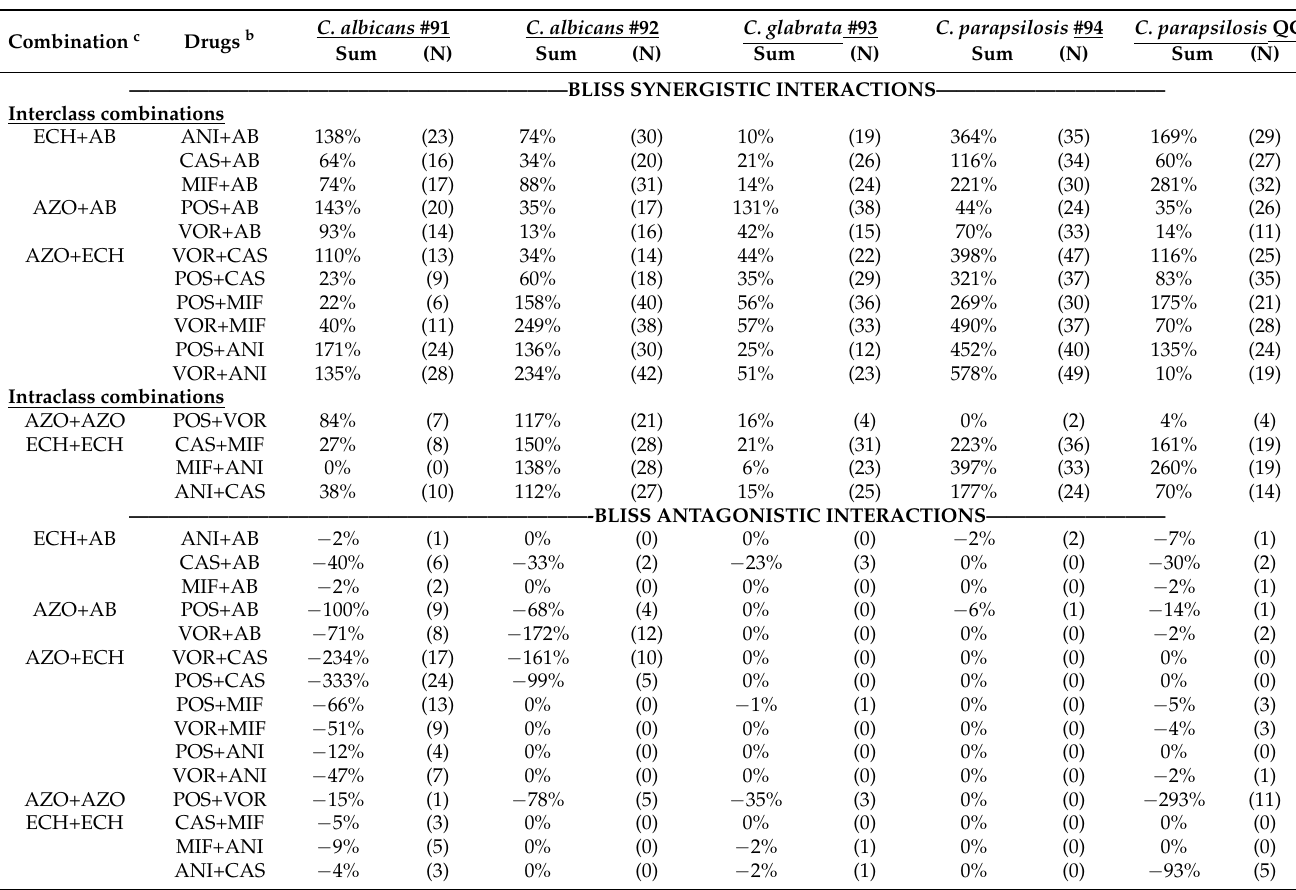
Table 3. Results of Bliss independence-based response surface analysis of two-drug combinations between echinocandins, azoles, and amphotericin B obtained from the 6 centers for each of the 5 Candida isolates